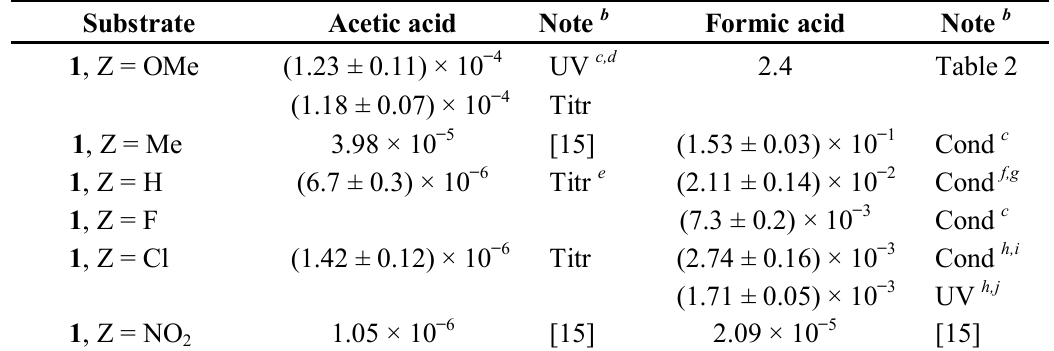
Table 3. Rate constants ( k /s − 1 ) for acetolysis and formolysis of p -substituted benzoyl chlorides ( 1 ) at 25 °C a